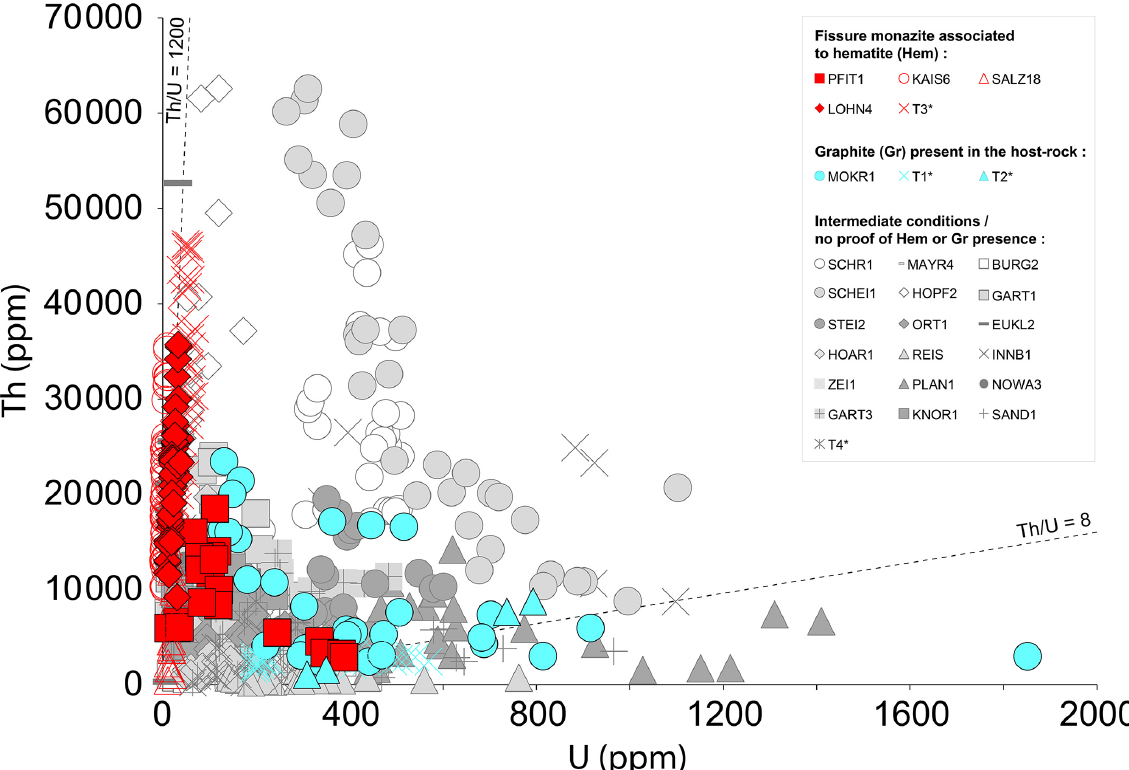
Figure 9. Th as function of U content obtained for all the monazite grains analysed in this study. Samples indicated by an asterisk are from Gnos et al. (2015). Fissure monazite grains associated with hematite (oxidizing conditions) are labelled in red, whereas grains hosted in graphite-bearing rocks (reducing conditions) are labelled in blue. Samples with intermediate composition and/or for which we have no information on the presence of hematite or graphite in the fissure environment are labelled in